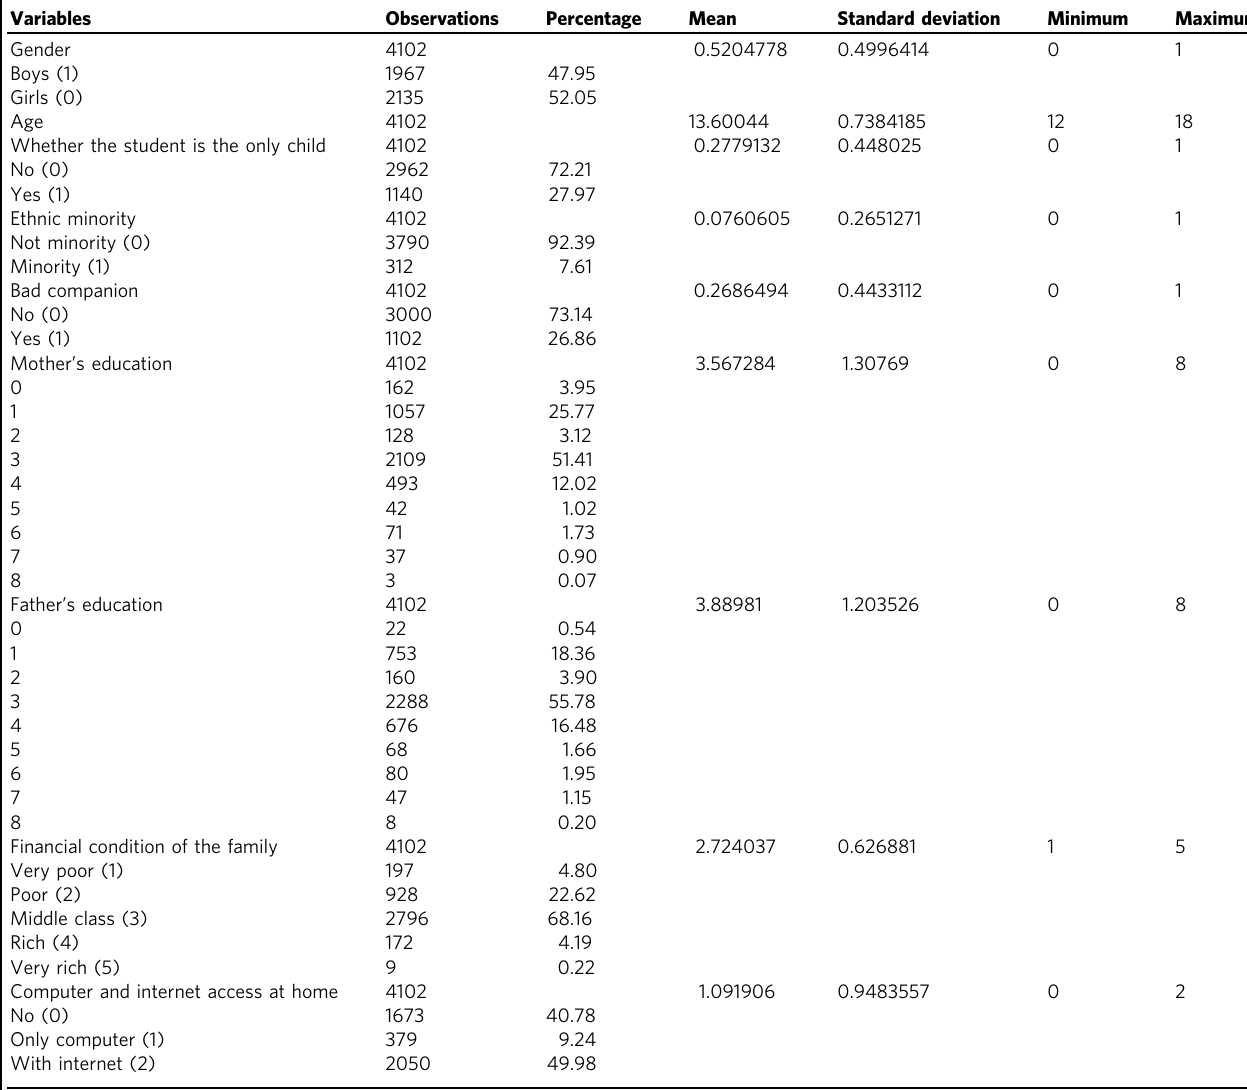
Table 1 Basic characteristics of sample students.